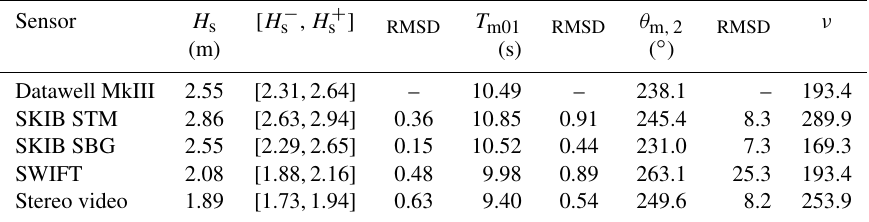
Table 1. Comparison of wave parameters, significant waves height ( H s ), mean absolute wave period ( T m01 ) and mean wave direction ( θ m , 2 ). The root mean square difference between Waverider and other sensors is given in a second column for each variable. [ H − s , H + s ] represents the maximum and minimum limits for 95% H s confidence interval, considering a chi square distribution (according to Young, 1995, Eqs. 5 and 6) for two perfect devices measuring the same random wave